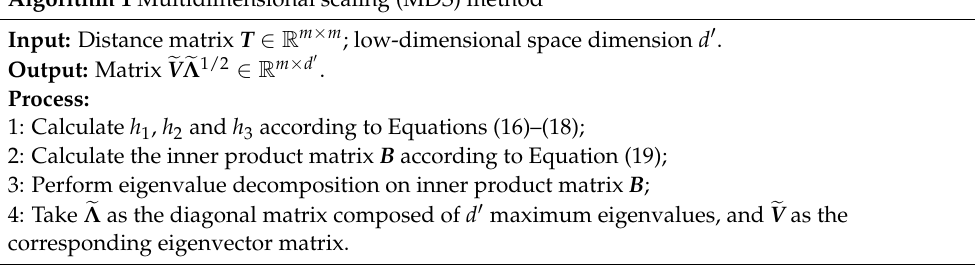
Algorithm 1 Multidimensional scaling (MDS) method